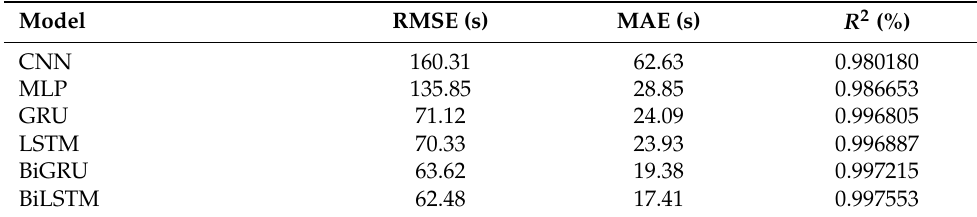
Figure 8. The loss curves of the BiLSTM (training and validation data). Table 3. The performance evaluation of the state-of-the-art deep learning